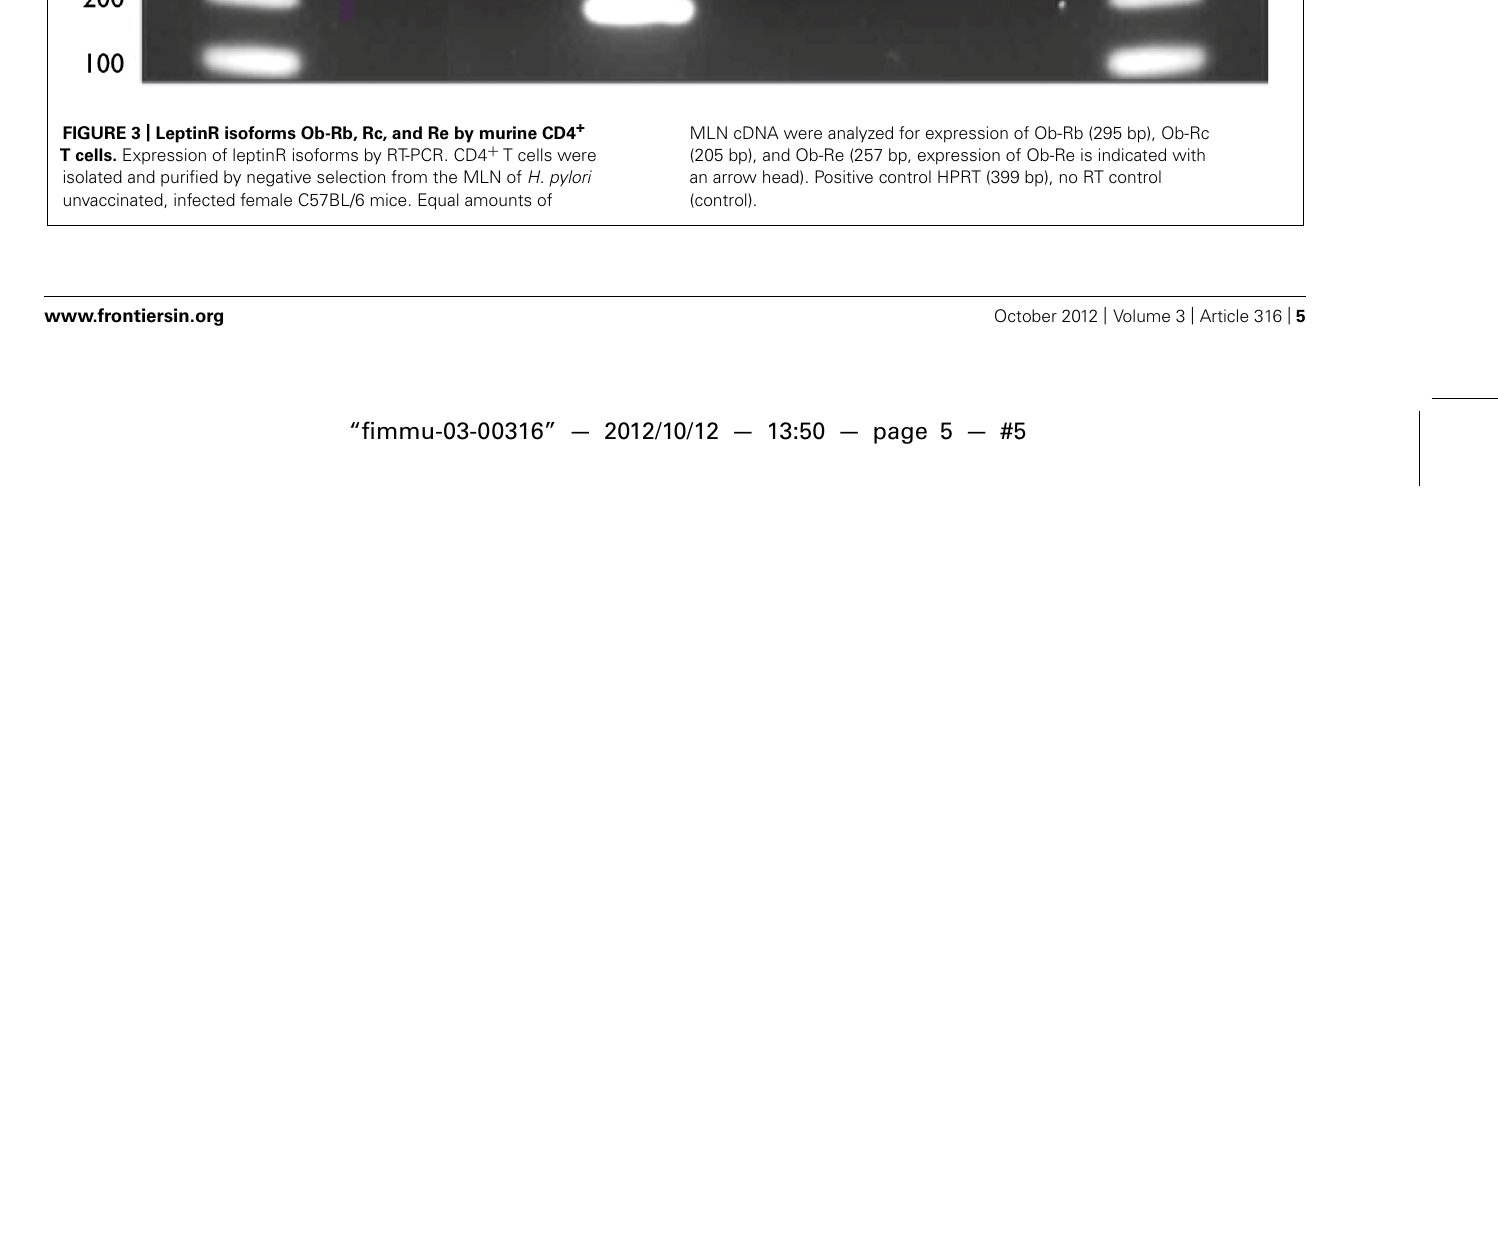
MLN cDNA were analyzed for expression of Ob-Rb (295 bp), Ob-Rc (205 bp), and Ob-Re (257 bp, expression of Ob-Re is indicated with an arrow head). Positive control HPRT (399 bp), no RT control